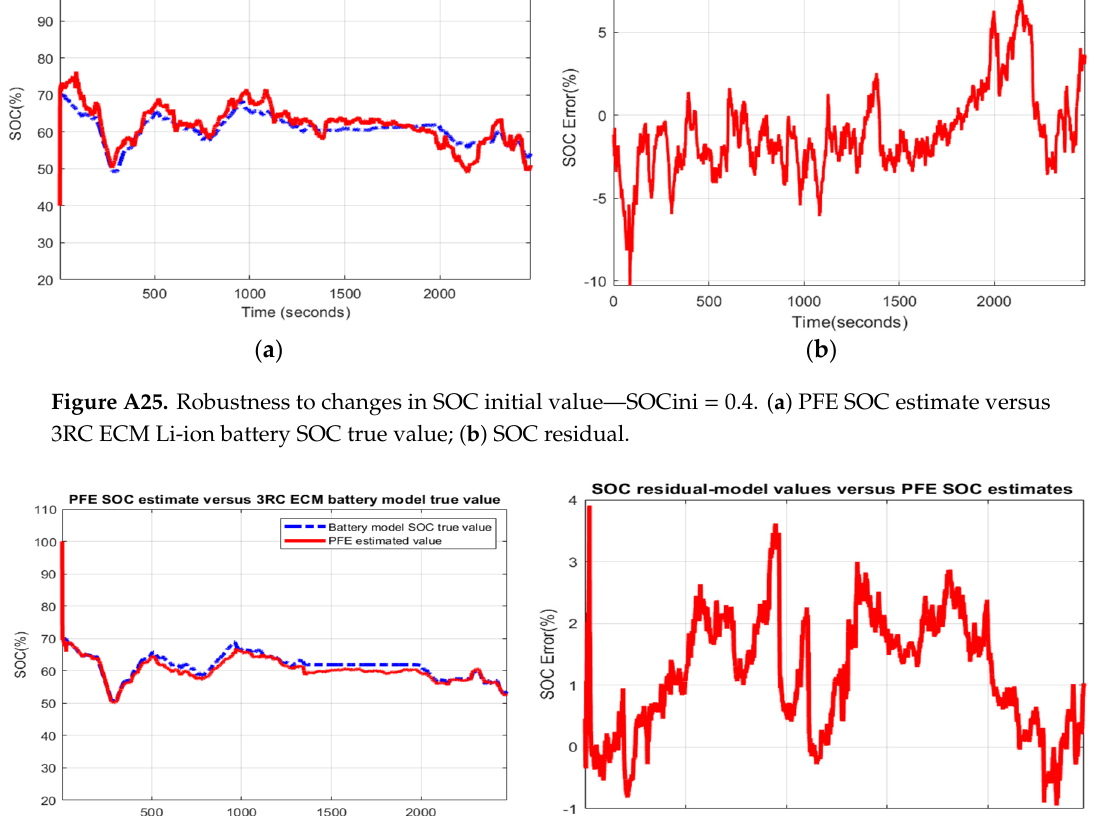
Figure A24. The MATLAB simulation results for Simulink Simscape Li-ion battery. ( a ) The PFE SOC value versus battery model SOC true value; ( b ) The PFE terminal output voltage versus battery 3RC ECM model terminal output voltage true value; ( c ) The SOC residual.